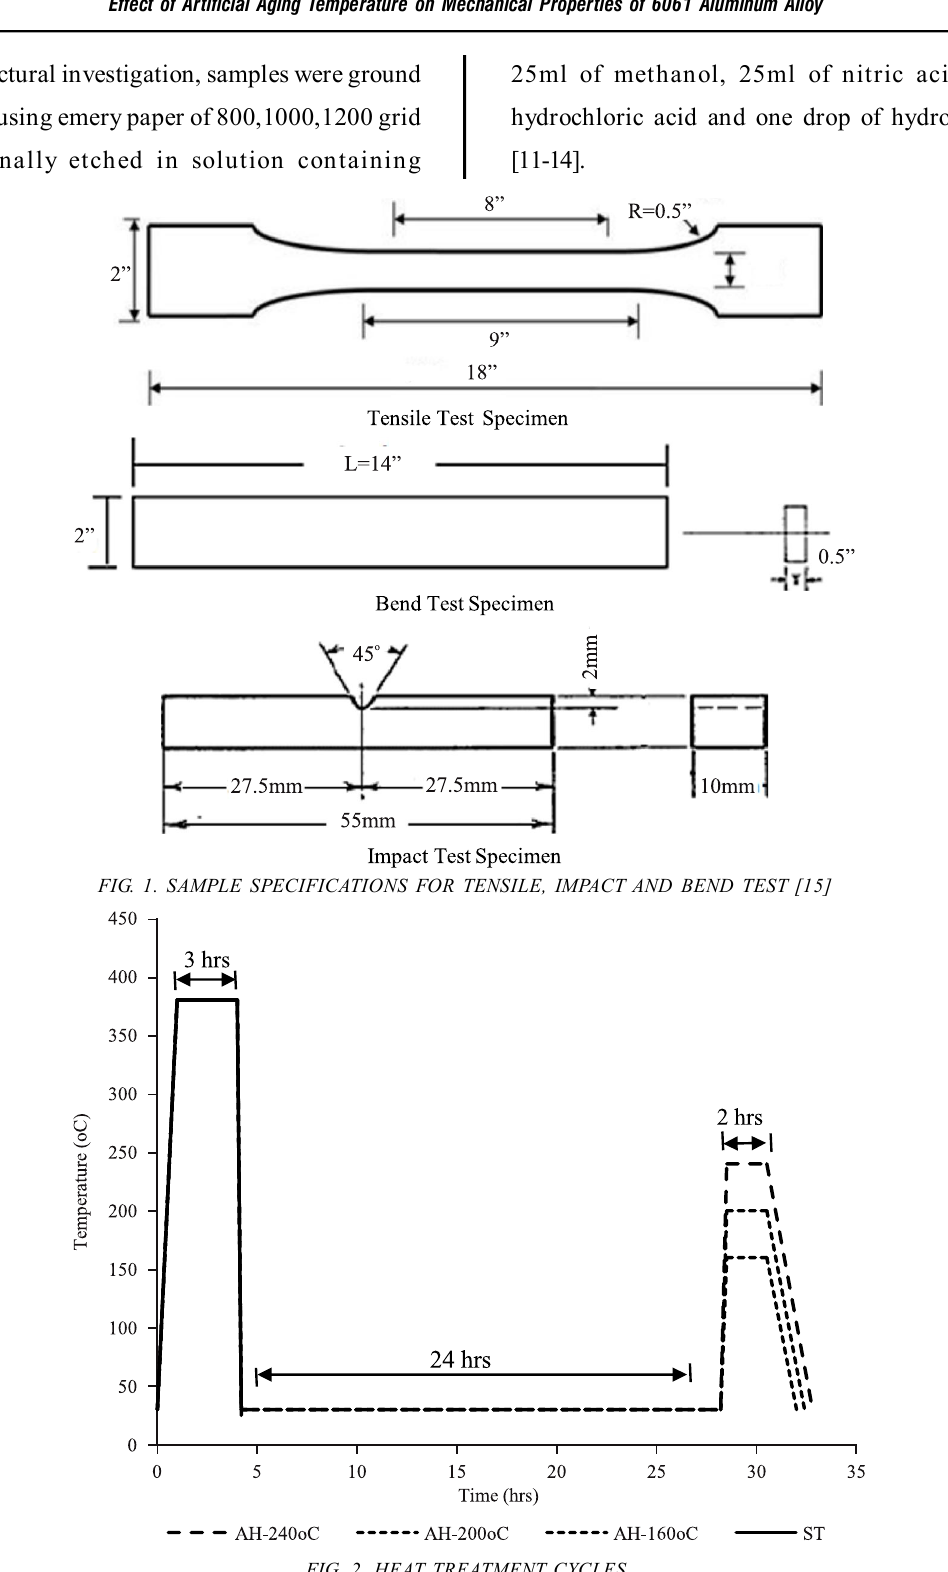
FIG. 2. HEAT TREATMENT